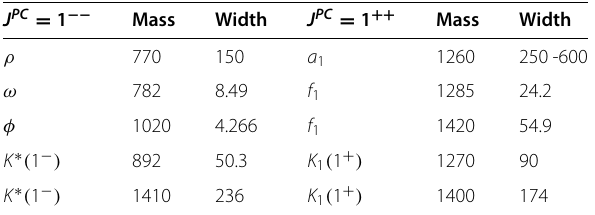
Table 1 Mass and width of vector and axial vector mesons. Units are in